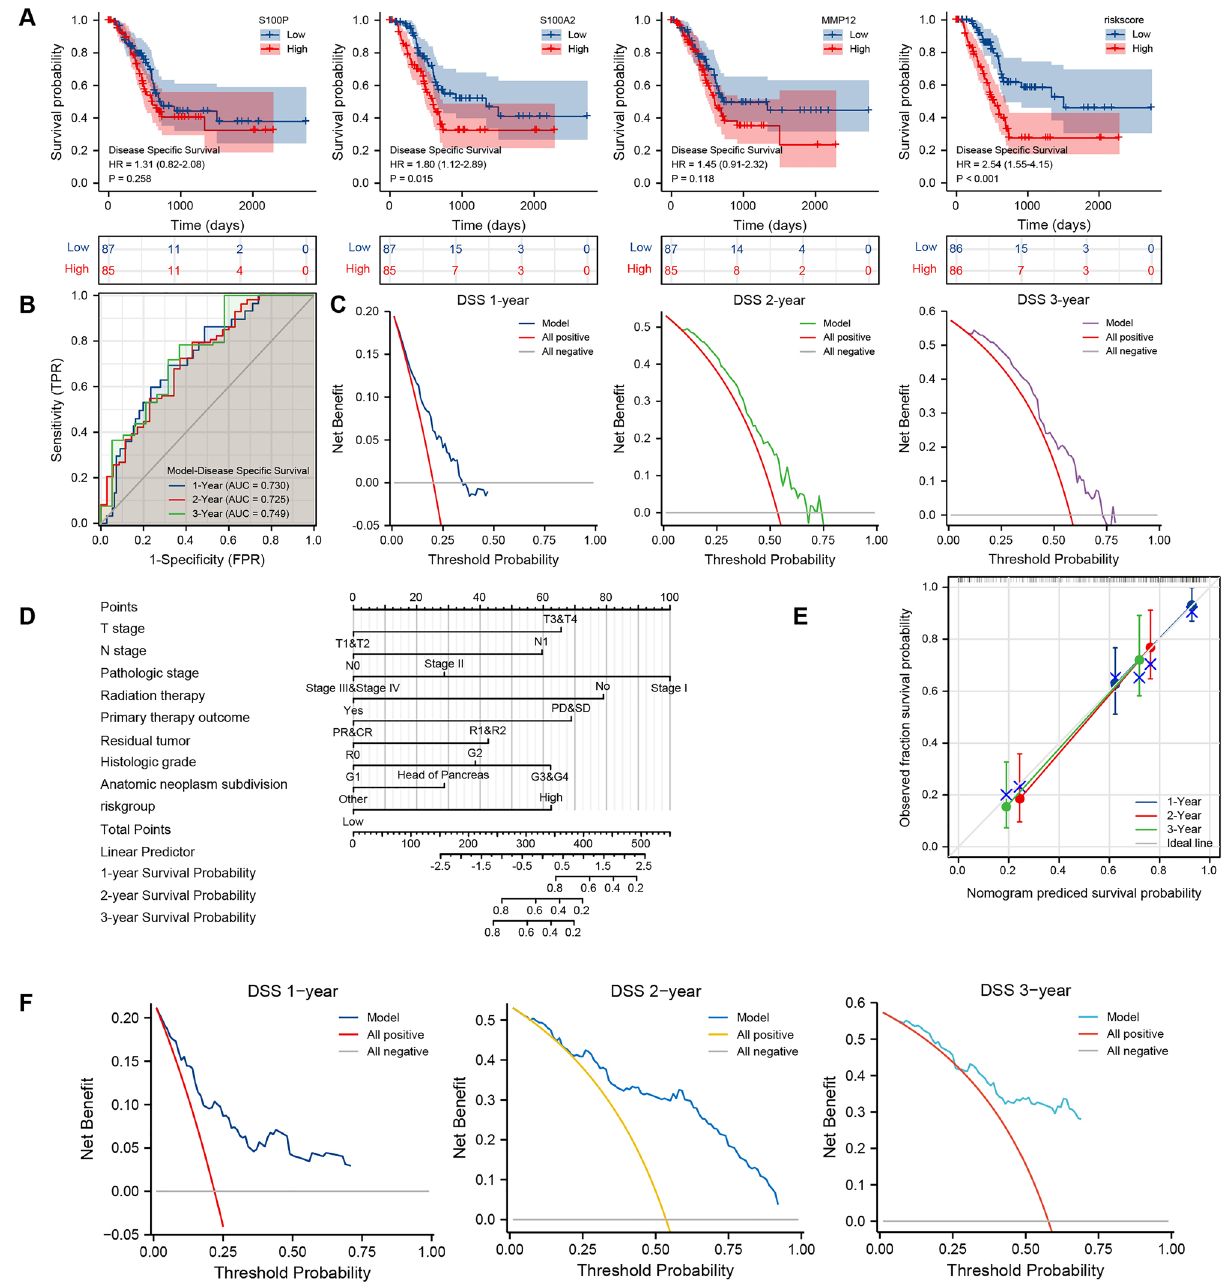
PAAD-IRGS for predicting 1, 2, and 3-year DSS; ( C ) decision curve analysis for evaluating the PAAD-IRGS; ( D ) an PAAD-IRGS-based nomogram included with 8 clinical components predicting 1, 2, and 3-year DSS of PAAD; ( E ) nomogram calibration curve for 1, 2, and 3-year. ( E ) Decision curve analysis for evaluating the net benefits of nomogram at 1, 2, and 3 years. DSS, disease-specific survival; * P < 0.05, ** P < 0.01, *** P <